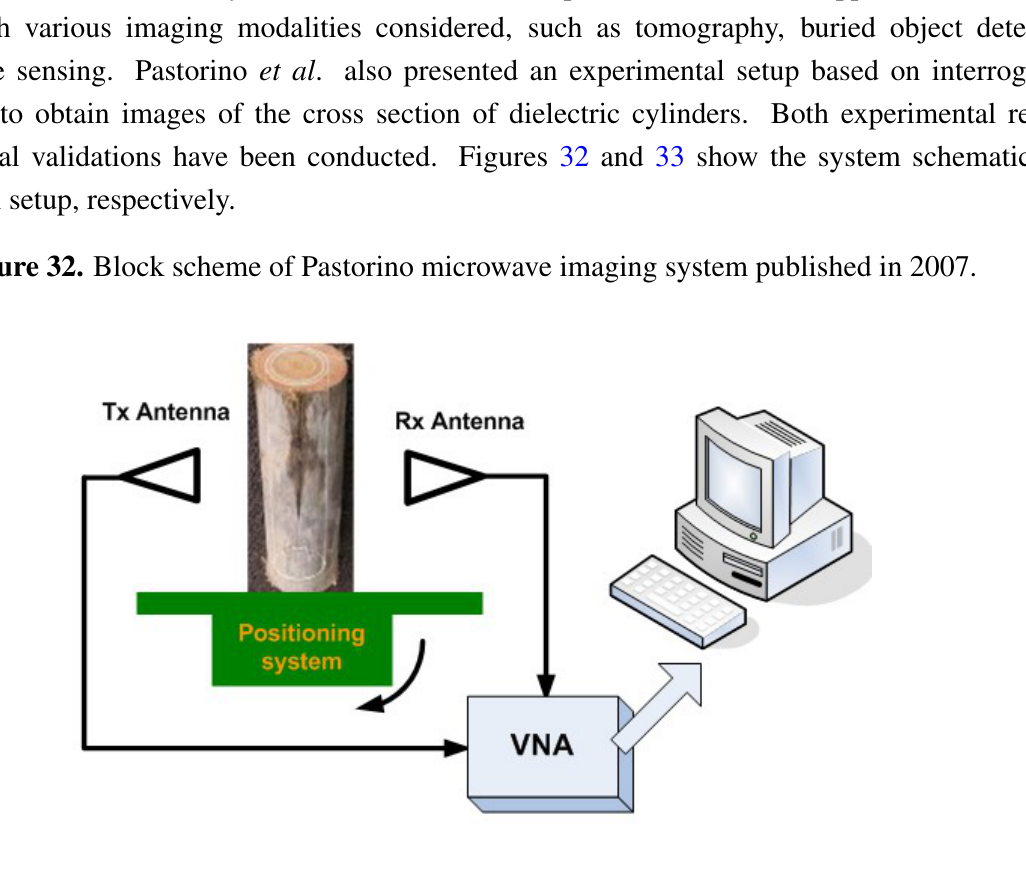
Figure 33. Pastorino microwave imaging system: illumination and measurement part of the experimental